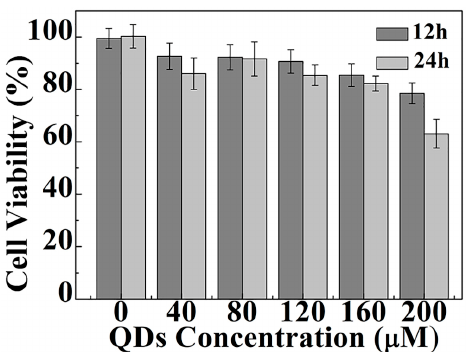
Figure 5. The viability of HepG2 cells with different concentrations of CdS QDs measured by MTT assay. Error bars represent the standard deviation of quadruple experiments.